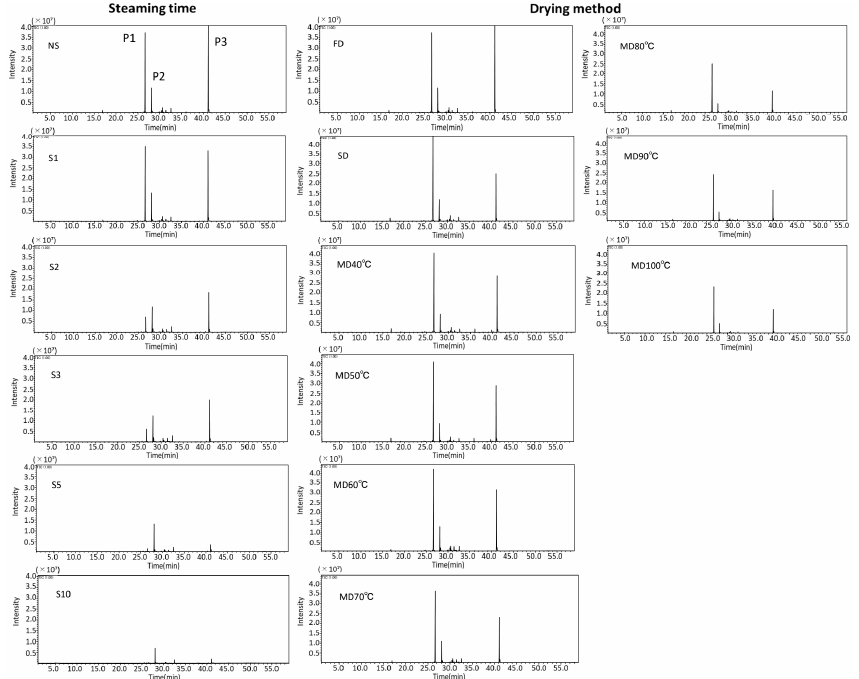
Figure 7. GC-MS chromatogram of Ocimum basilicum cv. ‘Genovese’ tea under different tea-making treatment conditions. FD: Freeze-drying (–56 °C, 48 h), NS: Non-Steaming, S1: Steaming for 1 min, S2: Steaming for 2 min, S3: Steaming for 3 min, S5: Steaming for 5 min, S10: Steaming for 10 min, SD: Shade-drying (25 °C, 7 days), MD 40 °C: Machine-drying at 40 °C, MD 50 °C: Machine-drying at 50 °C, MD 60 °C: Machine-drying at 60 °C, MD 70 °C: Machine-drying at 70 °C, MD 80 °C: Machine-drying at 80 °C, MD 90 °C: Machine-drying at 90 °C, and MD 100 °C: Machine-drying at 100 °C.